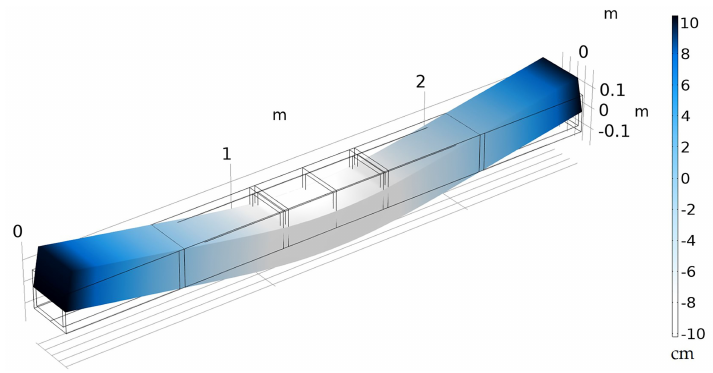
Figure 12. Representative load-deflection simulation with finite element analysis in